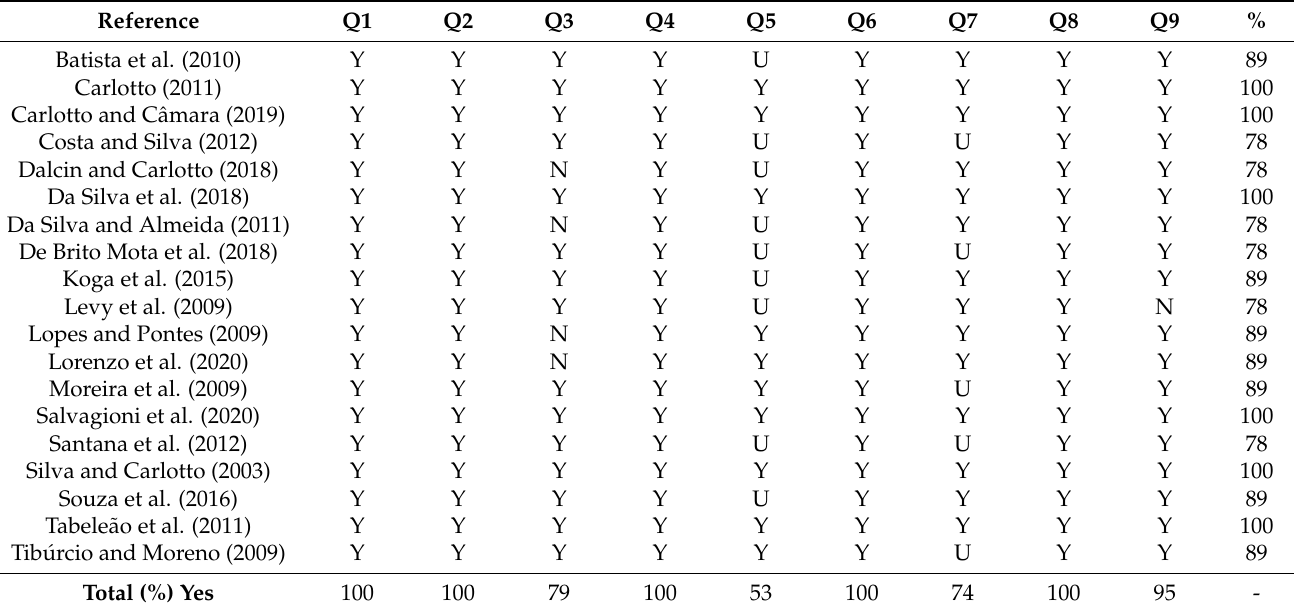
Table 2. Critical appraisal of the included